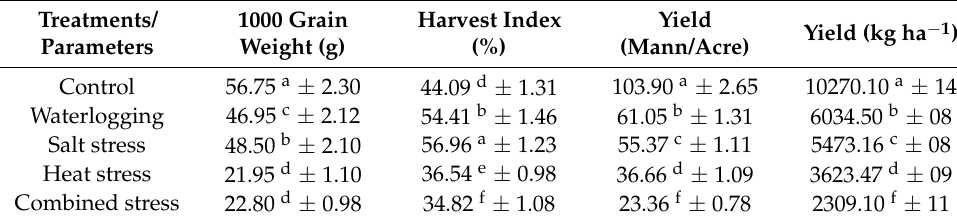
Table 1. Influence of abiotic stresses on the wheat yields after harvest.